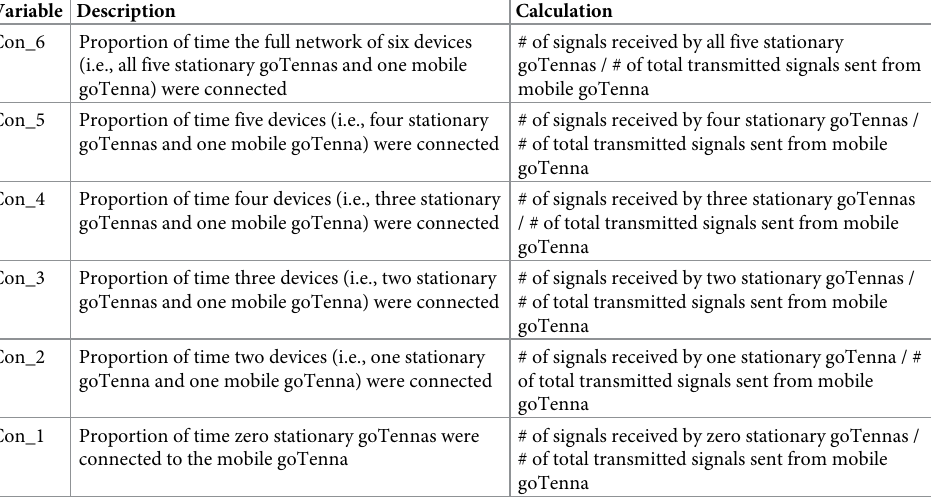
Table 3. Descriptions of the six compositional response variables representing the six connectivity levels and cor- responding calculation methods. Variable